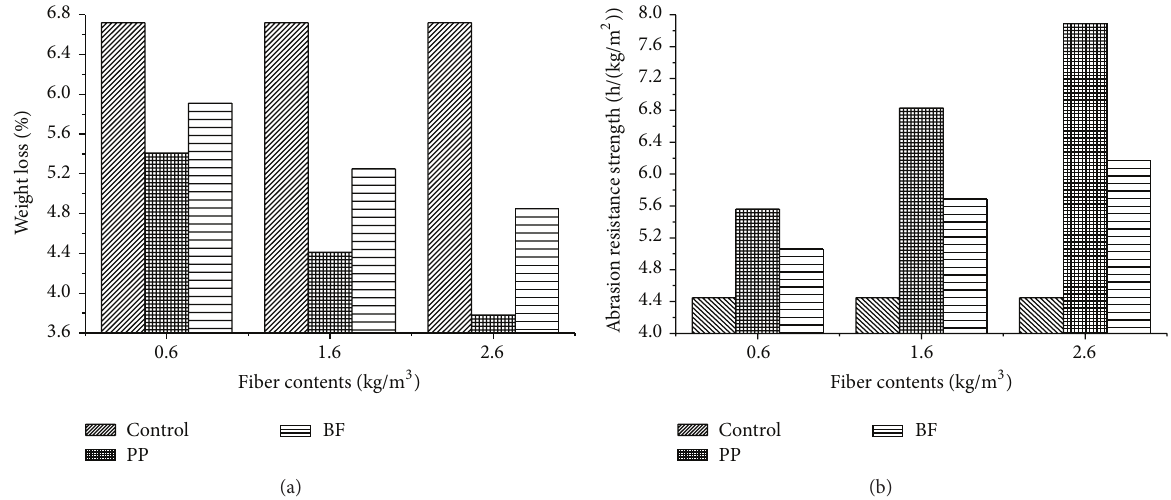
Figure 7: Abrasion resistance test results of FRM: (a) weight loss of FRM; (b) abrasion resistance strength of FRM.